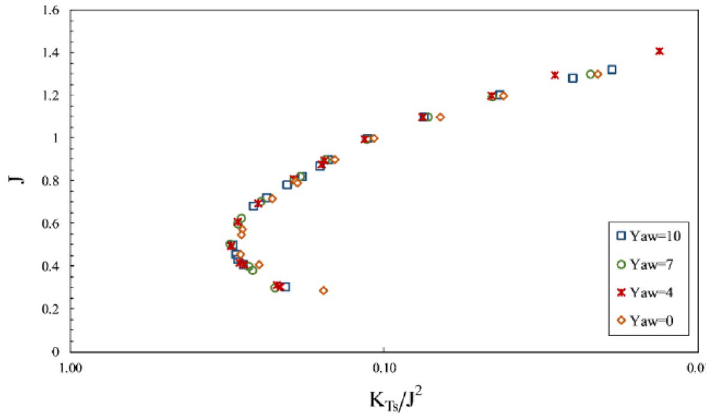
Figure 28. The effect of yaw angle on the thrust coefficient in the propulsion direction ( I = 0.4 ).